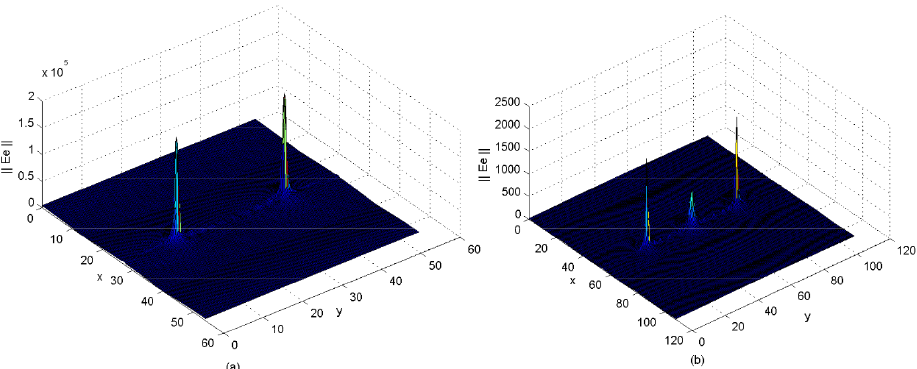
Figure 8. Electric field of 2D almost periodic array’s unit cell (half and full wave dipoles) defined by the guide wave’s aperture, described by the basis functions (guide’s modes) using: f = 5.4 GHz, α 0 = 0 rad m − 1 , β 0 = 0 rad m − 1 , w = 1 mm, δ = 0.75 mm ( w (cid:28) λ 0 , δ (cid:28) λ 0 ) , d x = 108 mm, d y = 108 mm. ≈ 27 mm; ( b ) L = λ ≈ 54 mm, h = 1.25 mm, and (cid:101) = (cid:101) r = 1 (air) (see [1] for ( a ) L = λ 0 0 2 a comparison).